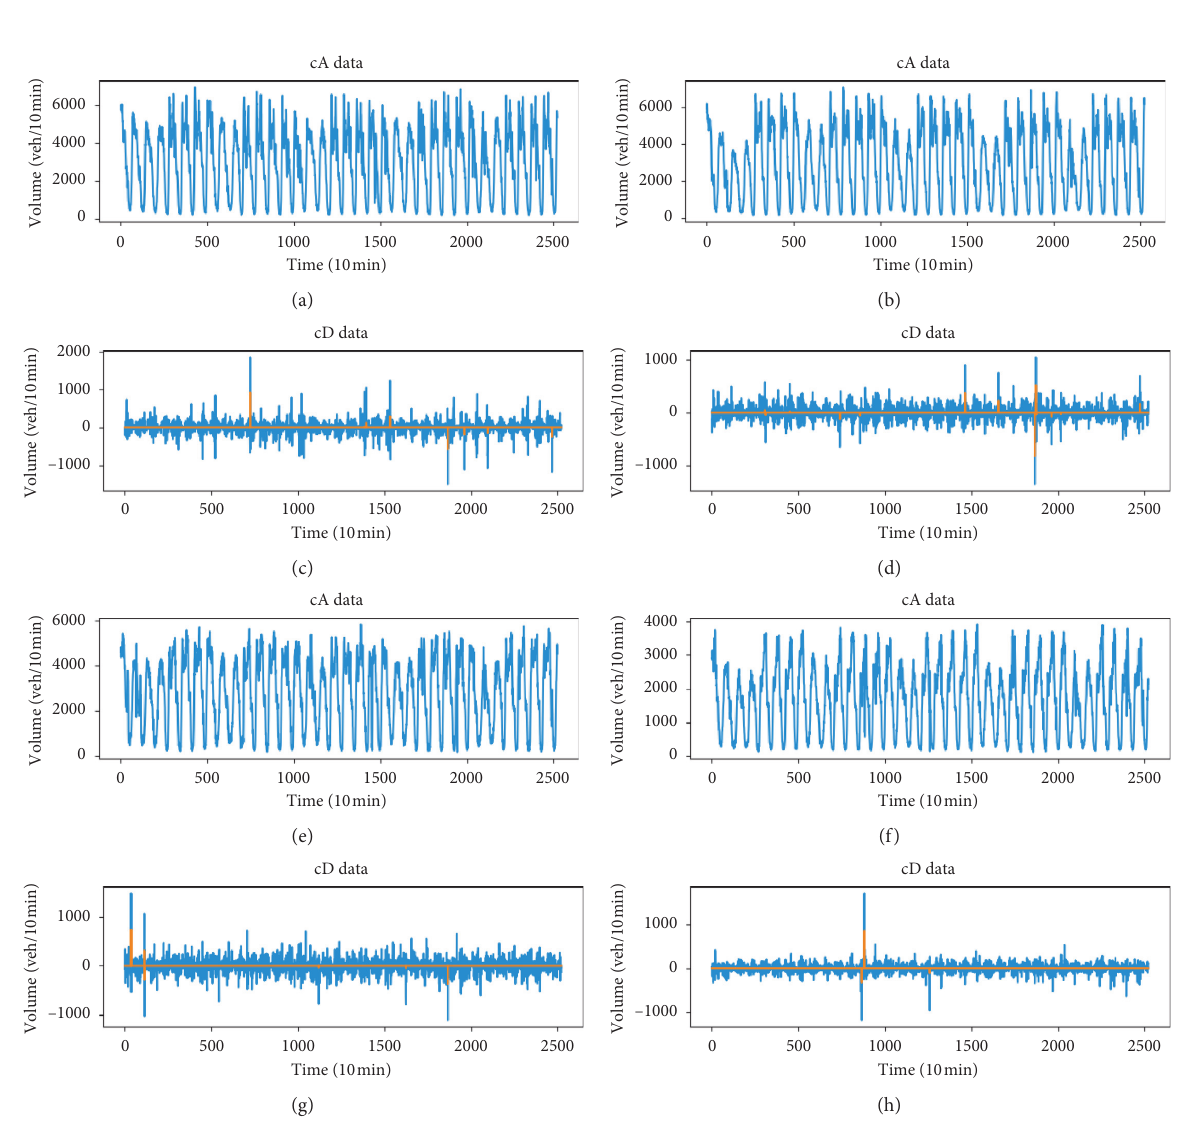
Figure 3: Denoising effect of traffic flow data with sensor A1 under 10min